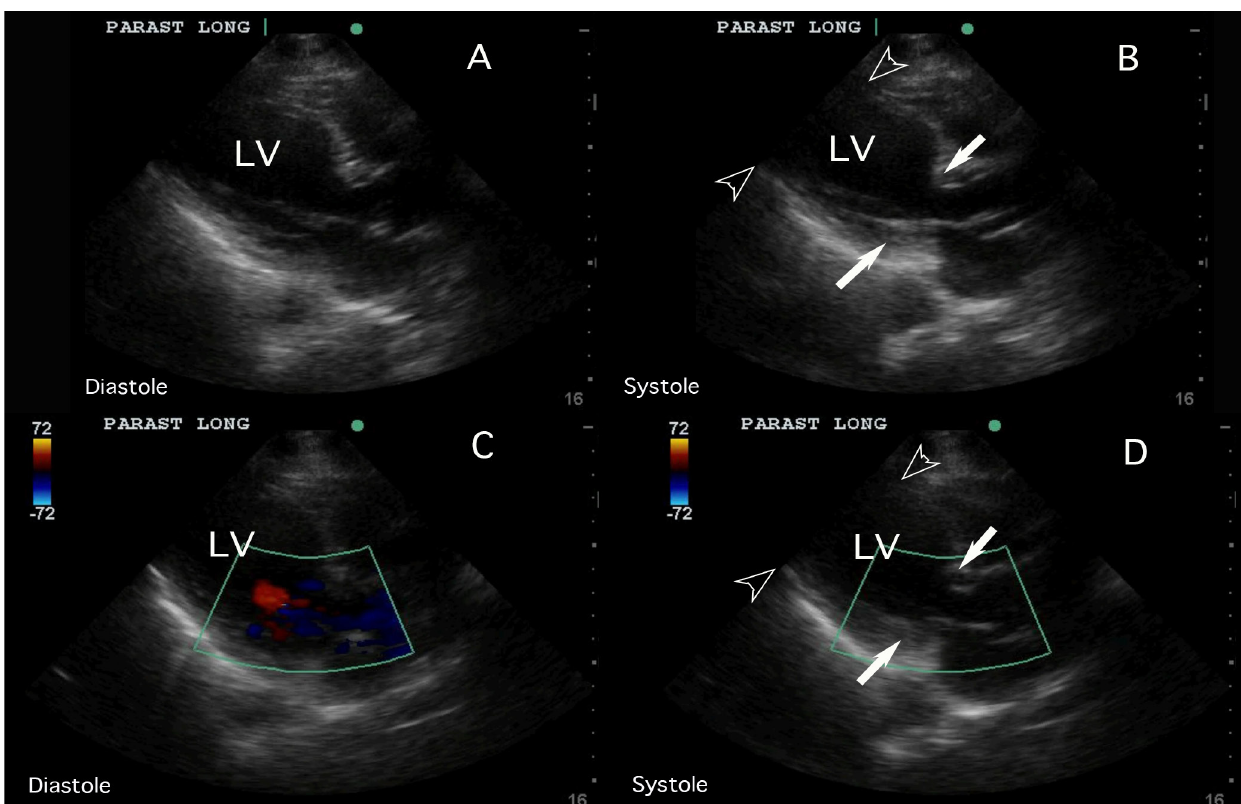
Image 2. These parasternal long-axis views, both with (panels C and D) and without (panels A and B) color, demonstrate the systolic apical ballooning of the left ventricle (LV) with preserved contraction of the basal segments. The apical portions of the interventricular septum and free wall of the left ventricle do not show significant movement when systole (panels B and D) is compared to diastole (panels A and C), indicating impaired contraction of the apical segment (outlined arrowheads). The left ventricular basal segments, however, move closer together in systole (panels B and D) to show preserved contraction of this portion of the heart (solid